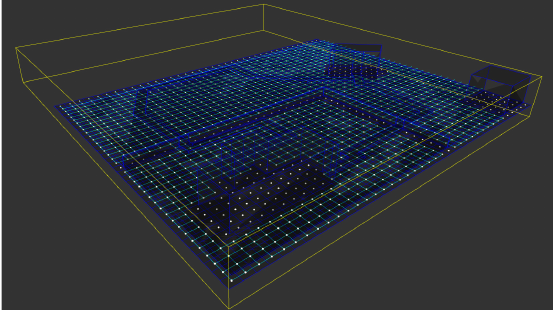
Figure 8. View of the final model of the use case with the